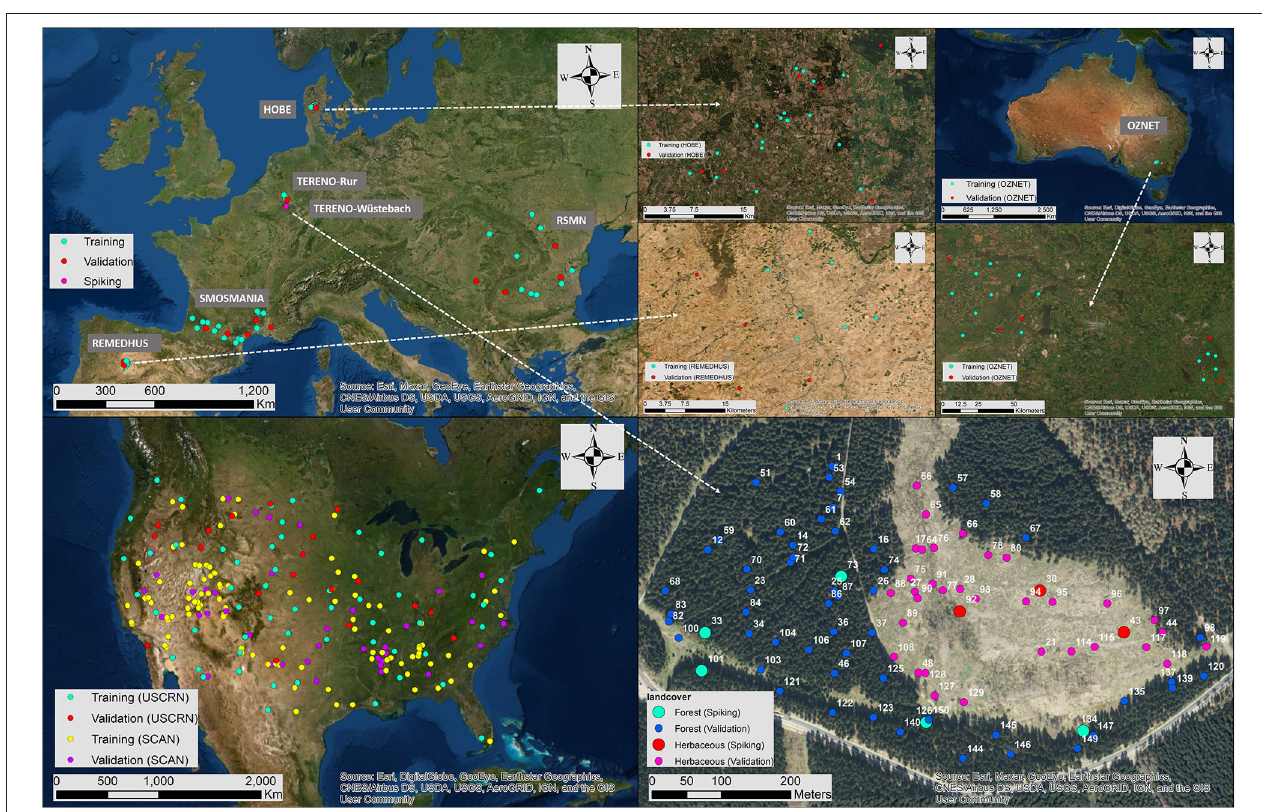
FIGURE 1 | Locations of continental—(SCAN, USCRN), regional—(HOBE, OZNET, REMEDHUS, RSMN, SMOSMANIA, TERENO-Rur), and field—(TERENO-Wüstebach) scale soil moisture networks. Training and validation stations from the continental- and regional- scale networks were highlighted in different colors and the local training (“spiking”) and validation stations from the field-scale network were marked in large and small solid circles,